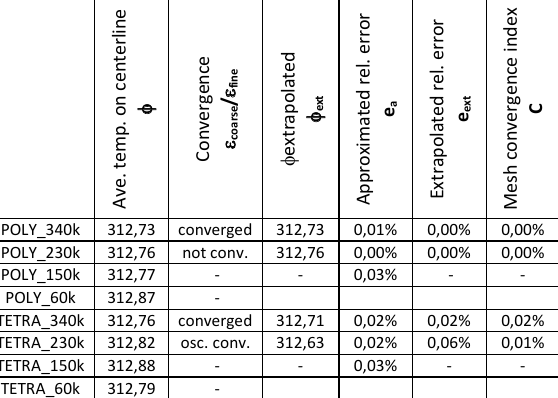
Table 1. Discretization errors.